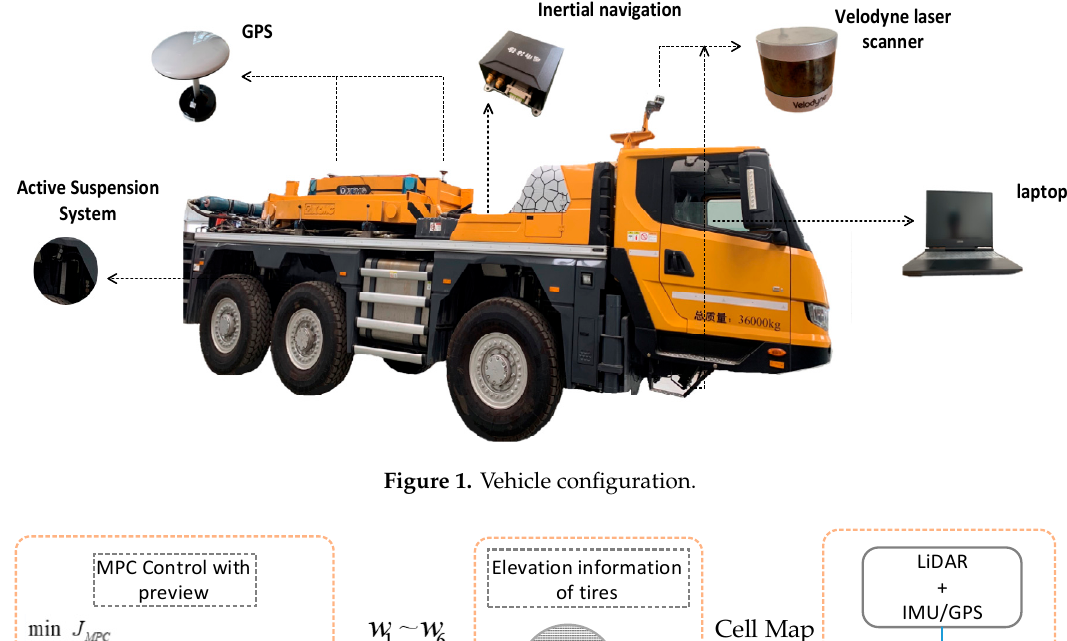
Figure 1. Vehicle configuration.